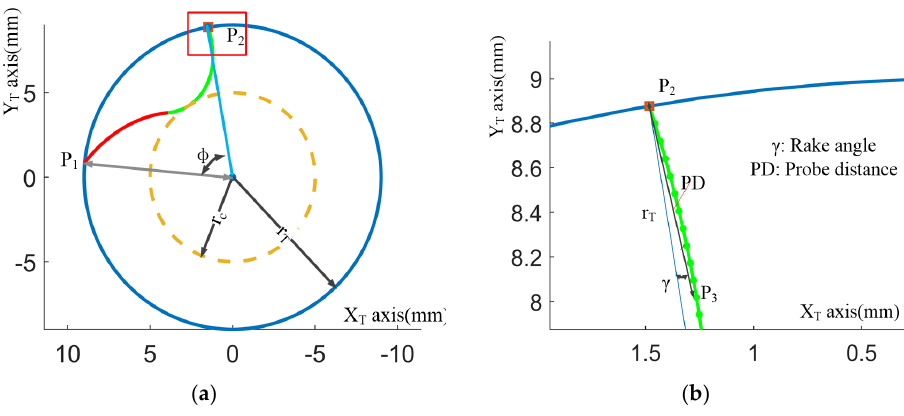
Figure 4. The flute parameters: ( a ) flute angle and core radius; ( b ) rake angle.